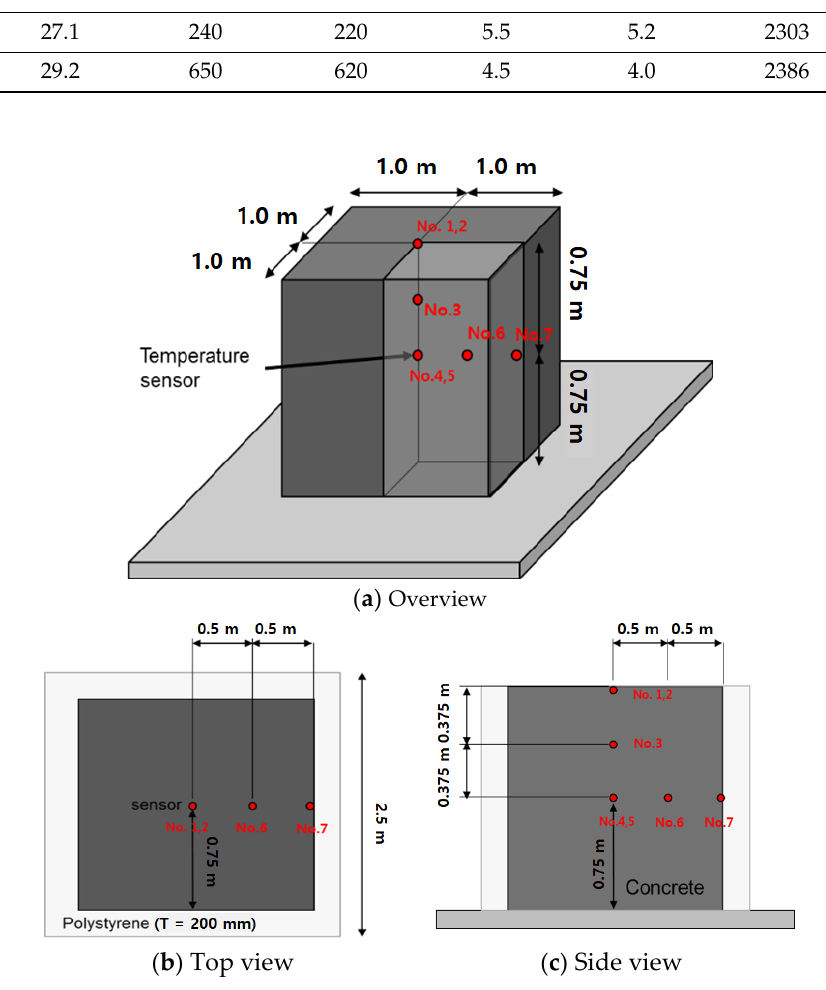
Figure 15. Locations of temperature sensors.